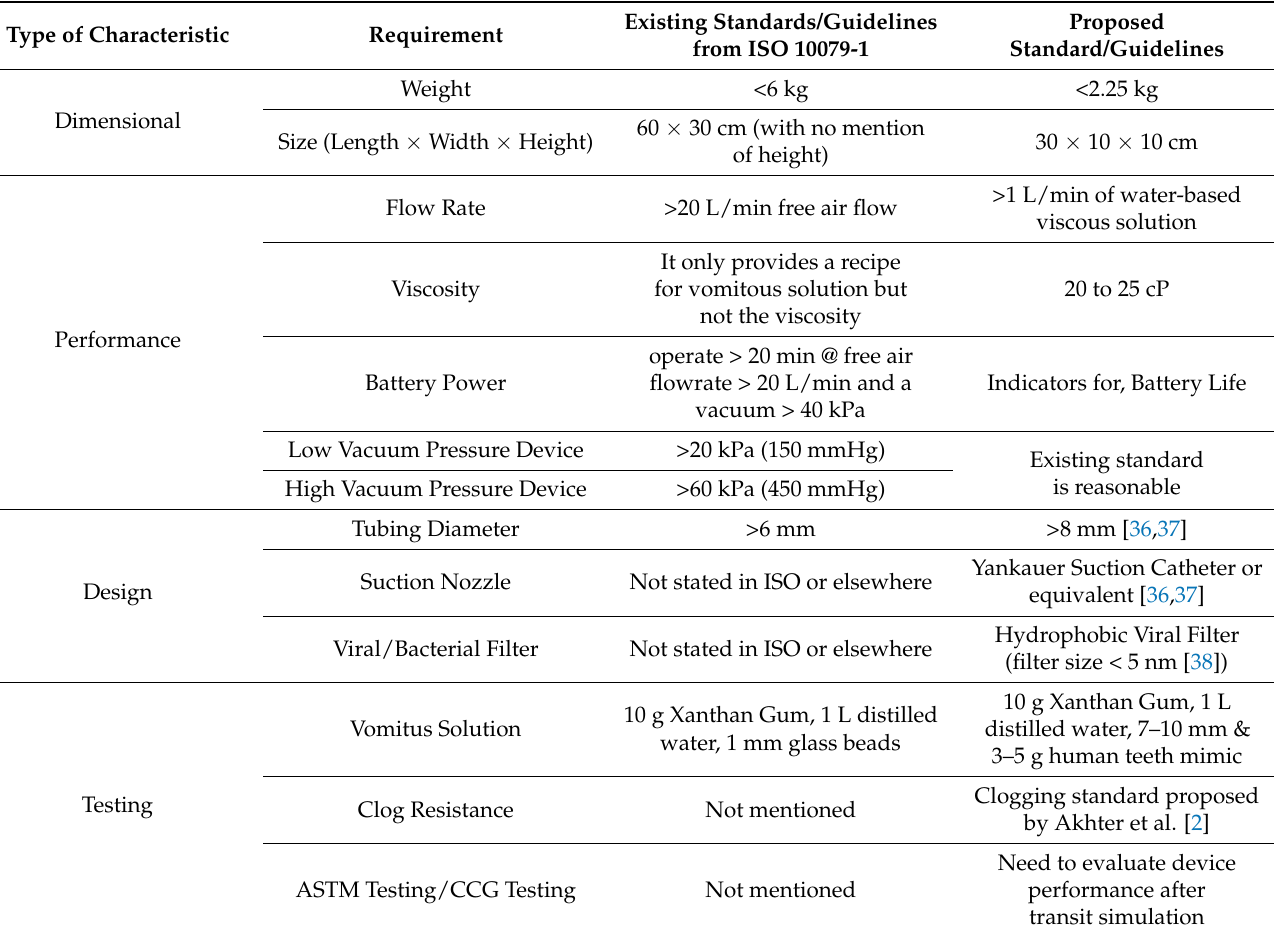
Table 2. New guidelines proposal for powered portable suction